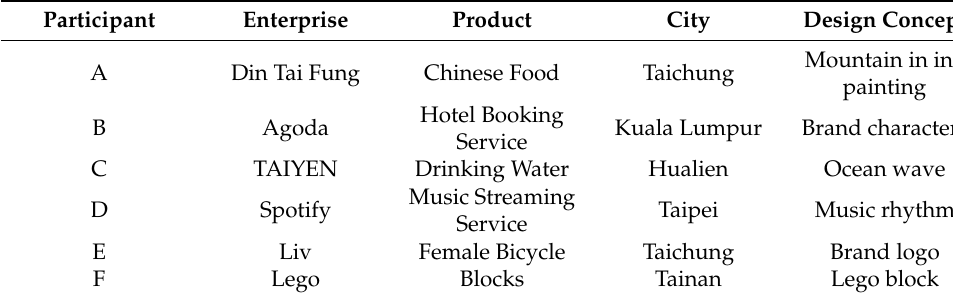
Table 3. The information of participants and their selected